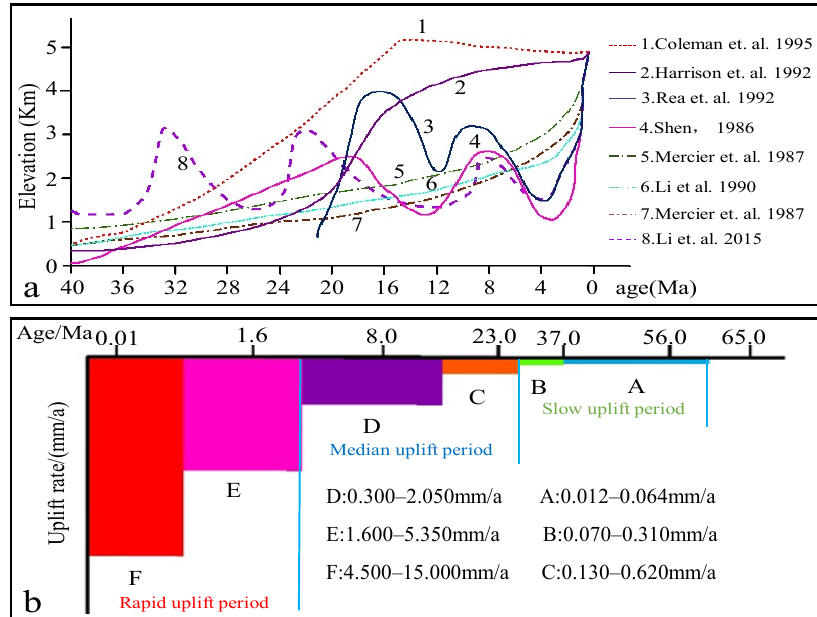
Figure 2. ( a ) Brief summary of the uplift history of the Tibetan Plateau [49], and ( b ) the uplift rate law of the Tibetan Plateau at different stages since the Cenozoic Era [49].